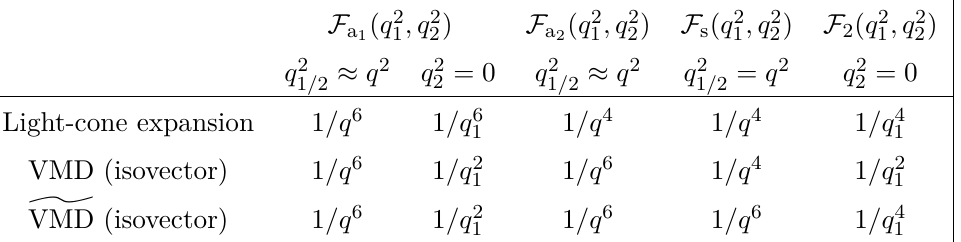
Table 2 . Comparison of the asymptotic behavior of the TFFs as predicted by the light-cone expan- sion, equation (3.29) and equation (3.30), with the implementation in the VMD representations, equation (3.10) and equation (3.20). The doubly-virtual limits of 1 /q 6 , so that the behavior of the light-cone expansion is reproduced by adding equation